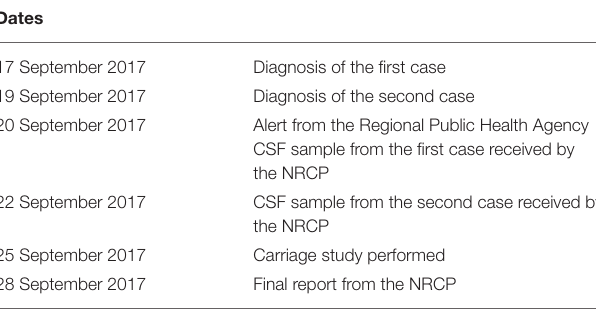
TABLE 1 | Case and investigation